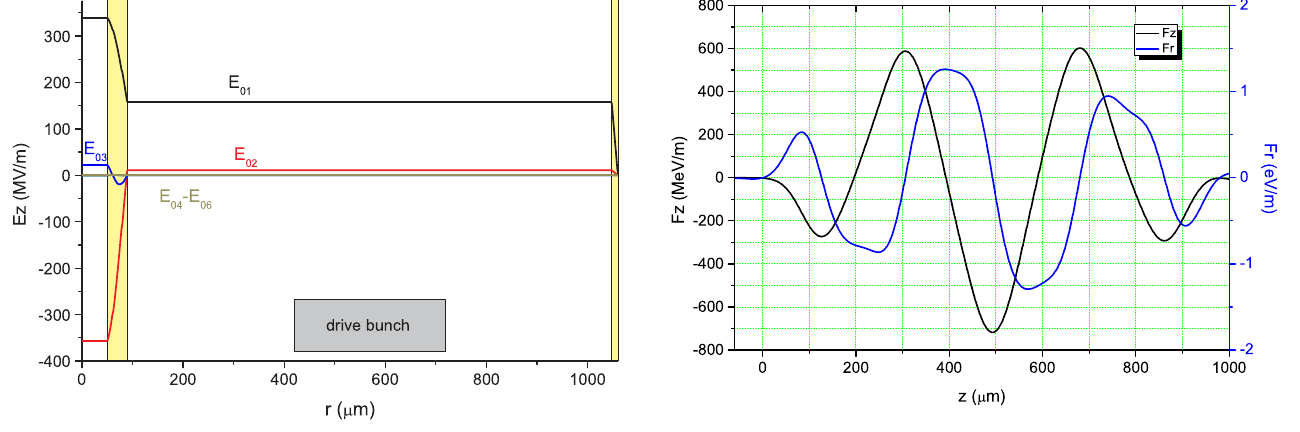
FIG. 5. (Color) Axial profiles of the composite transverse force I.FIG. 3. (Color) Transverse profiles E z ð r Þ for the first six TM (blue line) and composite longitudinal force (black line) acting operating mode. Locations of the two modes, with the E 02 on a test electron at the distance of 25 (cid:1) m from center of the dielectric shells is highlighted in yellow, and location and width accelerating channel. The drive bunch moves from right to left of the 5-GeV drive bunch is shown in and its center is located at z ¼ 0 . Parameters of the structure and drive bunch are given in the Table